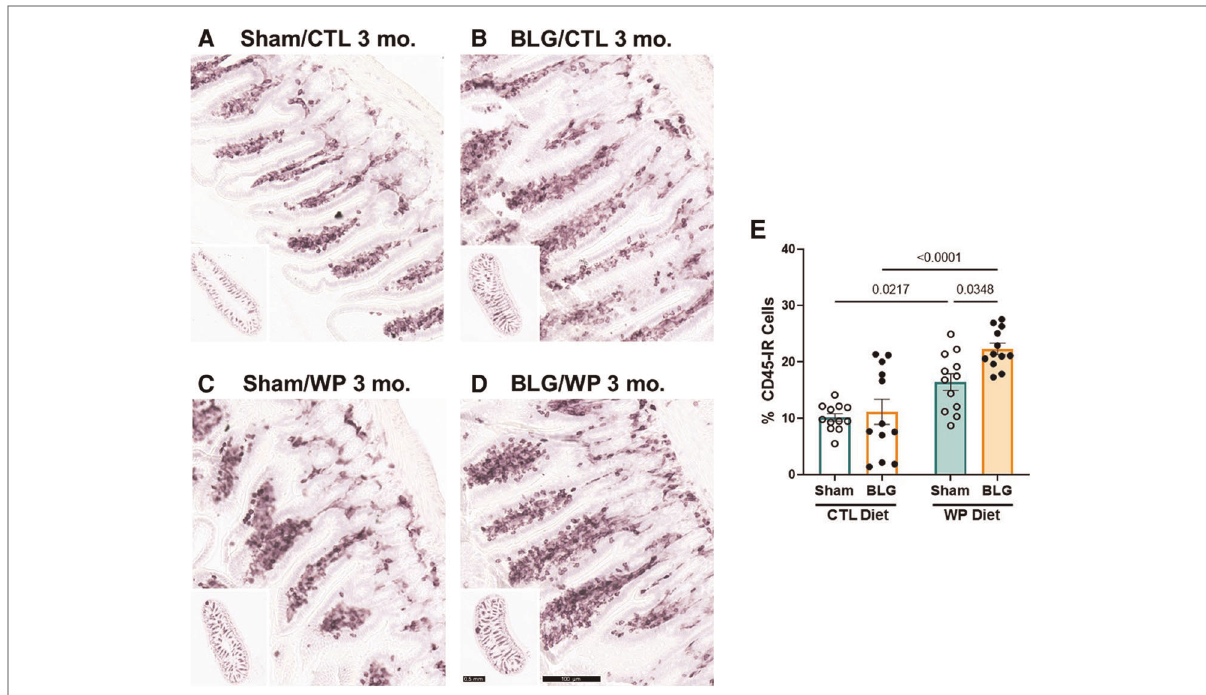
FIGURE 8 CD45-immunoreactive leukocytes in the intestine. Carnoy- fi xed paraf fi n-embedded intestines were sectioned and stained for CD45 immunoreactivity. Ileal sections from sham mice with the CTL diet ( A ); BLG mice with the CTL diet ( B ); sham mice with the WP diet ( C ), and BLG mice with the WP diet ( D ) are shown. The lower left inset in each panel shows the representative cross-section of the group at a lower magni fi cation. Scale bars: 100 μ m ( A – D ); 0.5 mm (insets). The percentages of CD45-IR cells within ileal cross-sections were quanti fi ed from three sections for each animal using the QuPath image analysis software ( E ). Values indicate the group average±SEM. Signi fi cant p -values are shown. Two-way ANOVA, n =12 per